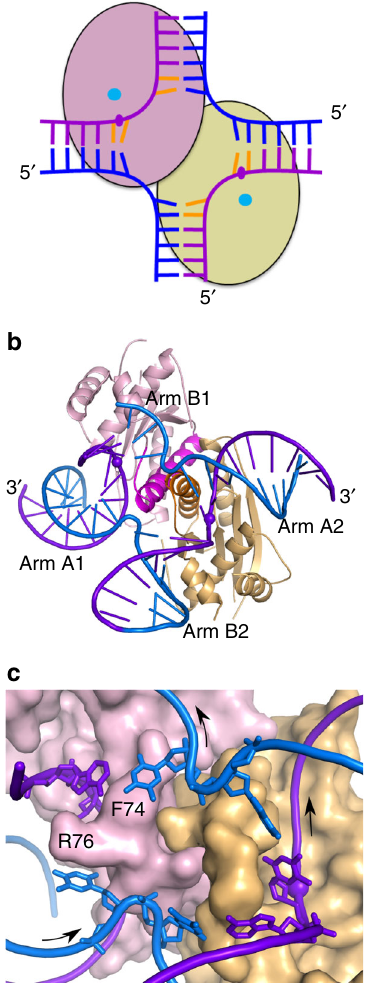
Fig. 1 Overall structure of Tt -RuvC – DNA complex and deformations of base pairing around the exchange point of the HJ. a Scheme of the complex structure. The subunits of the RuvC dimer are shown in pink and yellow green. The DNA is shown in blue (non-cleaved strands) and purple (cleaved strands) ladder-like representation. The scissile phosphates are shown as purple ovals, and the active sites are shown as cyan circles. The nucleotides of the consensus sequence are in orange. b Crystal structure of RuvC – HJ complex. The arms of the HJ are labeled, the scissile phosphates are indicated as spheres, and protein α -helices B with preceding loops that form the wedge element are shown in a darker color. Please note that both arm B1 and B2 are terminated with loops comprising three thymine residues, but in arm B1 loop is not visible in electron density maps. c Close- up view of the exchange point of the HJ. The protein is shown in surface representation, and the side chains of selected amino acids of the wedge element are labeled. Base pairs around the exchange point are shown as sticks. Arrows show the 5 ′ to 3 ′ polarity of DNA